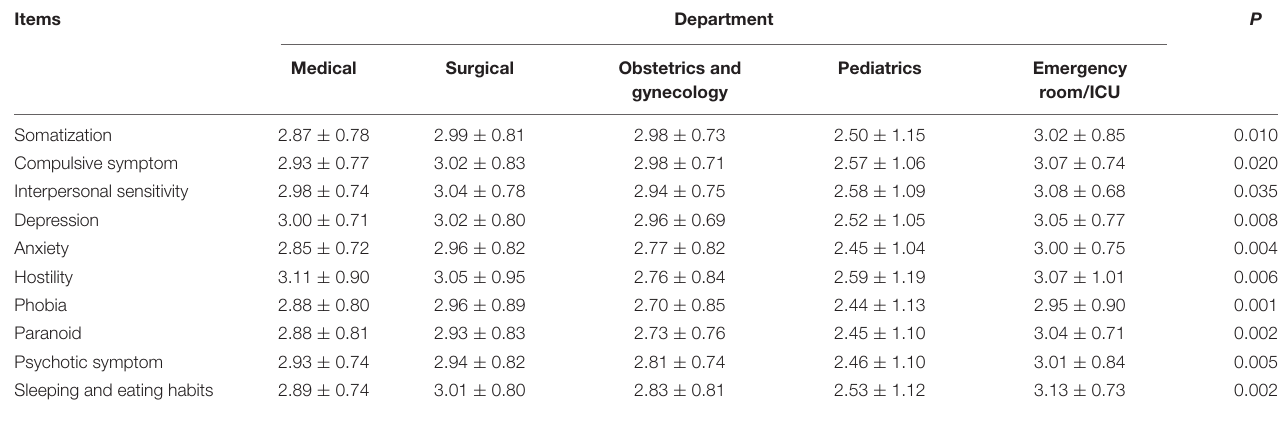
TABLE 1 | Scores of psychological symptoms among resident physicians in different specialties. Items